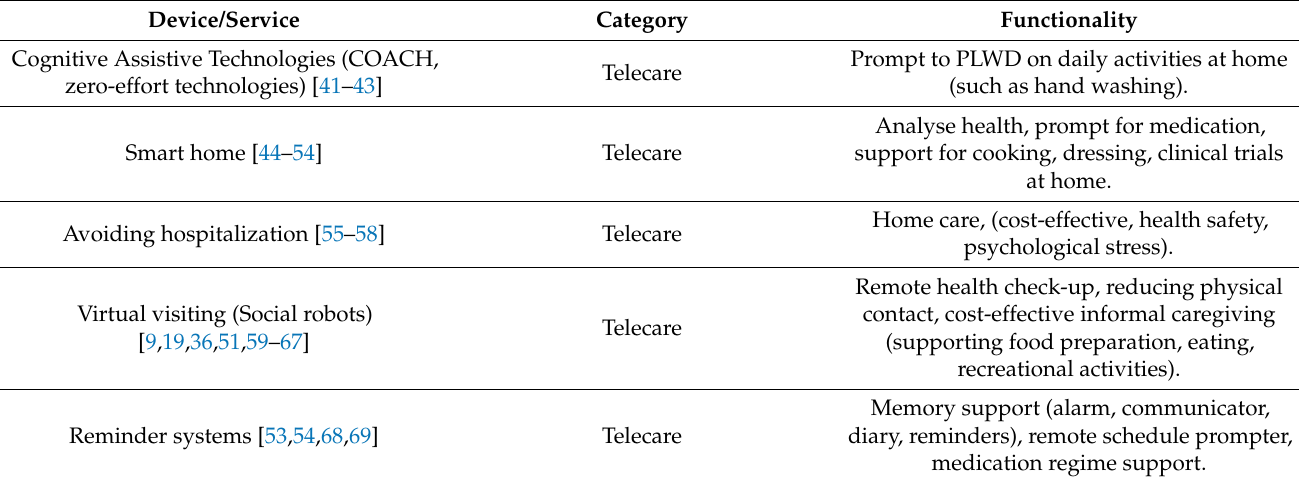
Table 1. Details about the categories and functionality of each article reviewed in this